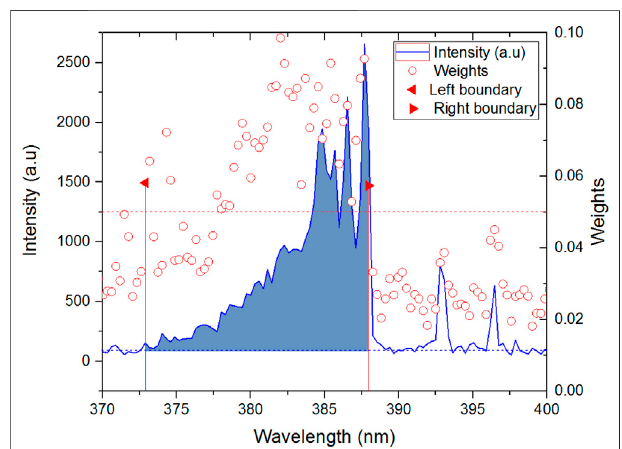
FIGURE8| AreacalculationofCNbandlineregionbasedonweightsby using the ReliefF algorithm. The weight threshold determines the boundary of area,whichisusedtobuildtheSVMmodel.Thereddottedlinerepresentsthe weight threshold (0.05). The blue dotted line represents the base